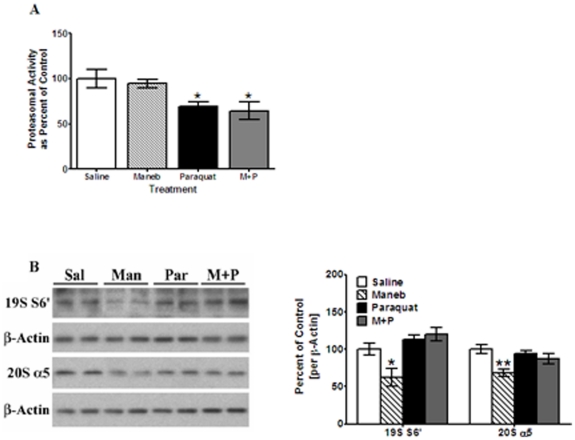
Effect of maneb and paraquat on proteasomal activity.(A) Prior to setting up the assay protocol, brain samples were extracted by sodium cholate, and sample assays from both insoluble and soluble fractions ranged from 579–3845 units and 31,000–78,000 units, respectively, indicating that the solubilization protocol was working optimally. Aliquots from soluble extracts were used to measure 26S proteasomal activity as described under “Materials and Methods”. Lactacystin-sensitive digestion of the model substrate suc-LLVYAMC was used to measure 26S proteasome activity, expressed via AMC fluorescence. (B) Samples were further homogenized in a modified RIPA buffer containing 1.0% sodium cholate, and analyzed by Western blots. After exposure to initial antibodies, blots were stripped and probed for other proteins. The blots show representative gels while the bar graphs are composites summarized from all animals (n = 5–6). Proteasomal proteins 19S and 20S were probed using antibodies specific for the 19S 6S′ subunit and 20S α5 subunit, and expressed relative to β-actin used as loading control. Values are mean ± SEM as compared to saline injected control. Asterisks (*, **) indicate values significantly different from saline controls (p<0.05, p<0.01, respectively). Student's t-test was performed to compare control and treatment groups for all data.